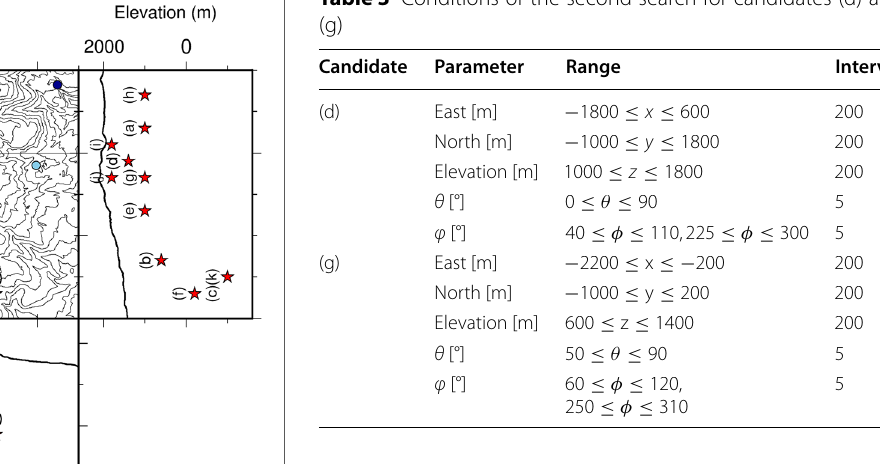
Table 4 Summary of the second waveform inversion results.